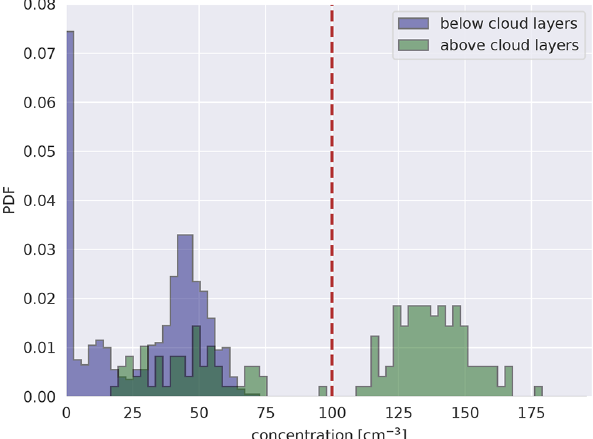
Figure 4. The probability density function (PDF) of aerosol con- centrations (for aerosol particles of diameters between 80 and 1000nm) as observed by the UHSAS-2 mass spectrometer on P6 during the southern racetrack section of RF20. The southern race- track is shown in Fig. 1b, which was in this region between 15:40 and 17:10UTC. The time resolution of the observation is 3s. The red dashed line indicates the initial CCN concentration used in the simulations (Zanatta and Herber, 2019; Mertes et al.,